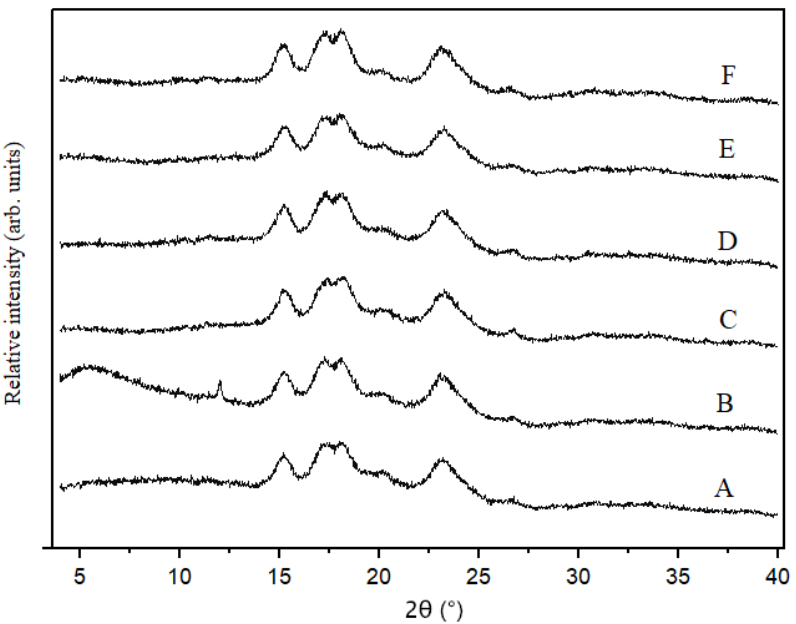
Figure 2. X-ray diffraction patterns of millet starches—A: barnyard millet; B: finger millet; C: foxtail millet; D: kodo millet; E: little millet; F: proso millet.